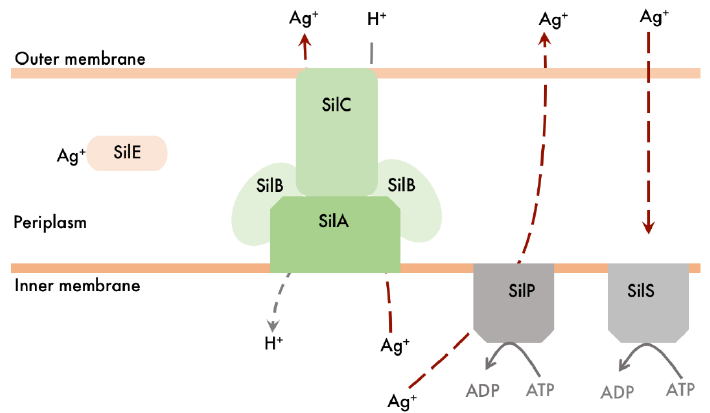
Figure 4. Silver efflux system found in Gram-negative silver-resistant bacteria. SilE is a periplasmic, histidine-rich Ag + binding protein; SilS belongs to a two-component (SilRS) transcription